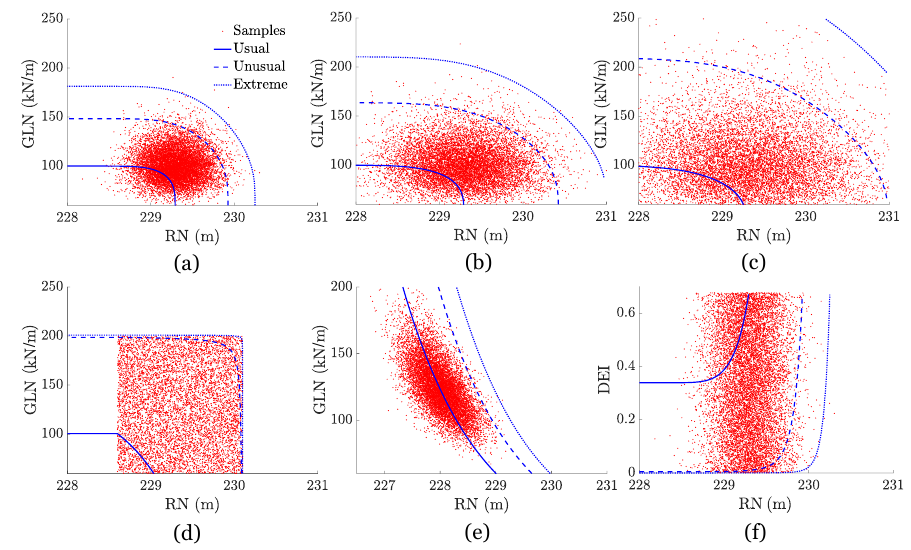
Figure 7. LC regions for RN-GLN: ( a ) D1, ( b ) D2, ( c ) D3, ( d ) D4, ( e ) D5, and ( f ) D6. Table 5. Considered LC distributions.